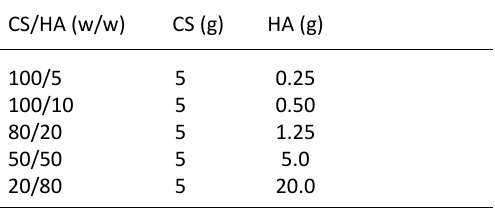
Table 1. The ratio of Chitosan/ Hydroxyapatite